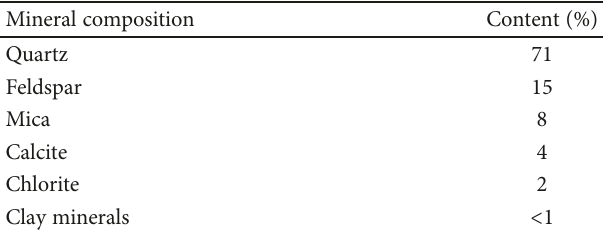
Table 1: Mineral composition of sandstone